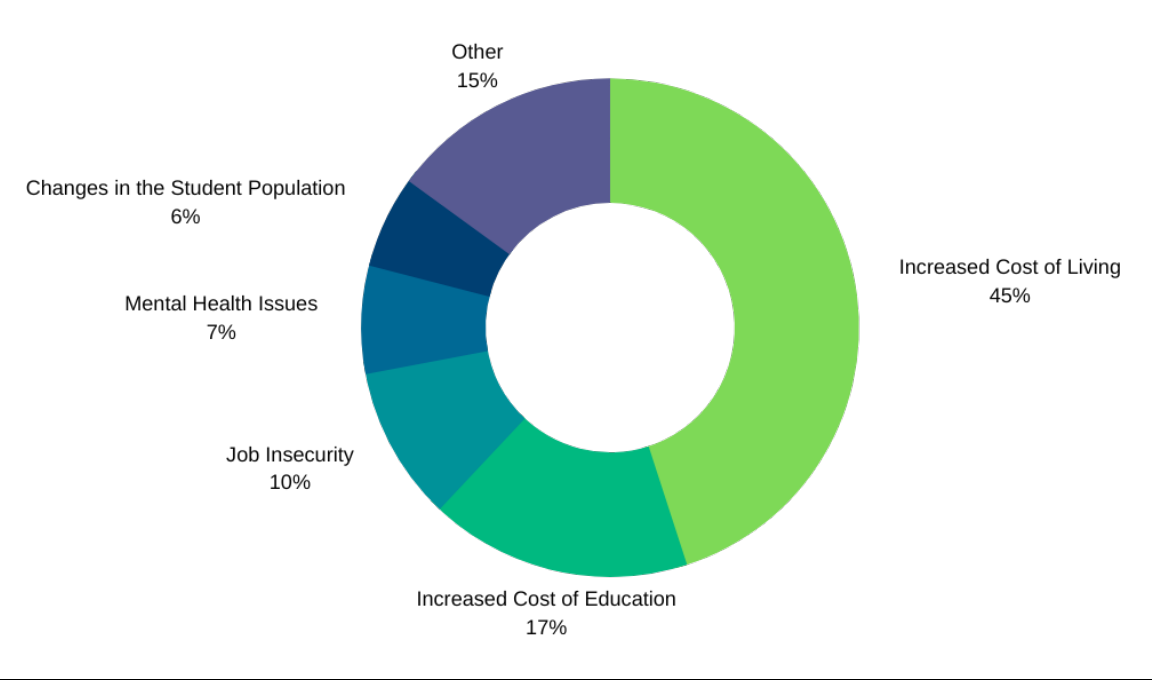
Data: Graphs Over Time activity in the student